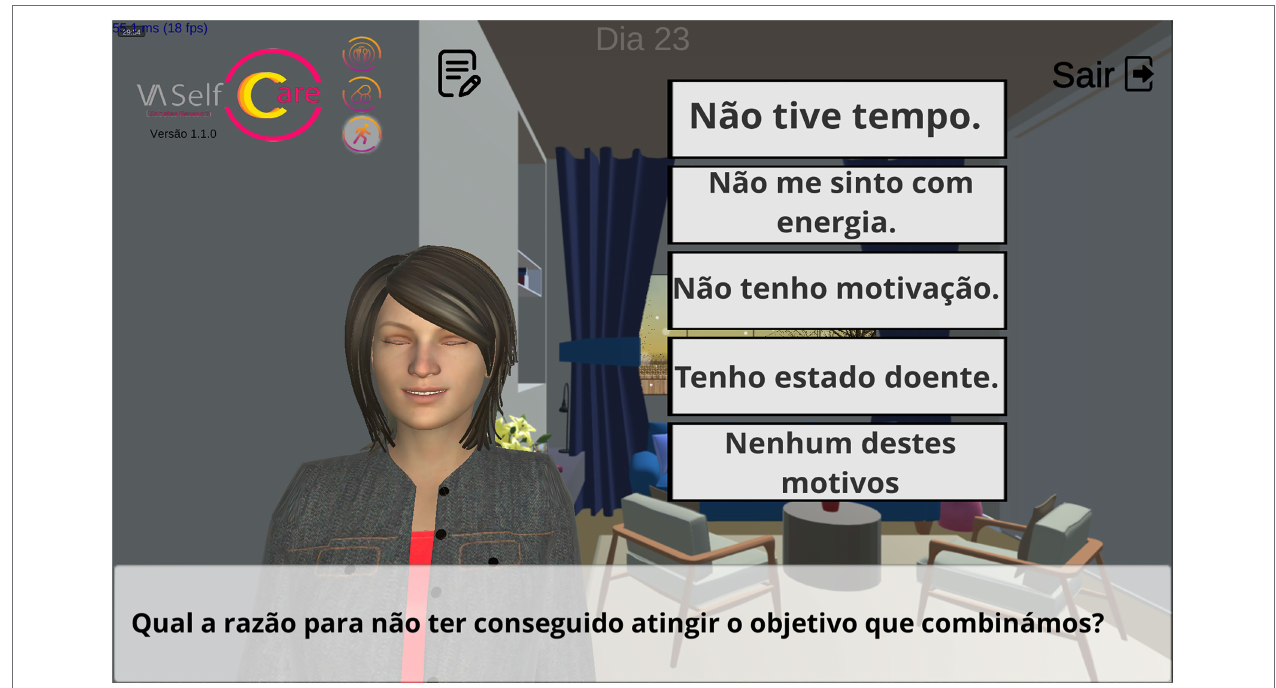
FIGURE 6 | Interface of the mobile application: Vitoria addressing barriers to walking (problem-solving 1.2). Translation to English: What is the reason for not having achieved the goal we agreed upon? (subtitle); (A) I did not have time; (B) I do not feel energetic; (C) I am not motivated; (D) I have been sick and (E) None of these reasons (response options).